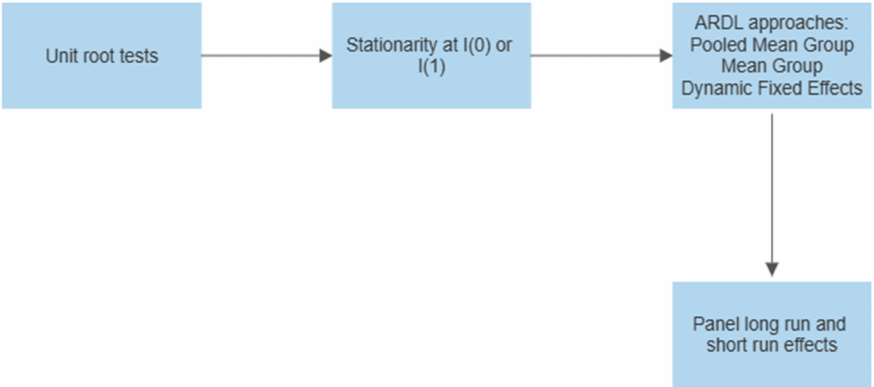
Figure 1. Flow chart of the